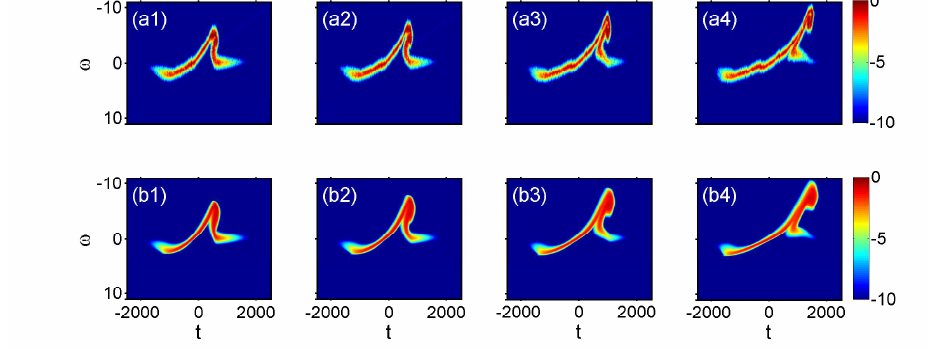
Figure 5. ( a ) Post-collapse dynamics: Numerical simulation of the Vlasov Equation (2) showing the evolution of the intensity of the incoherent pulse N ( t , z ) at the propagation lengths z = 0,80,130,180,220,250,280,310,340, 370,400,430,470,500: The collapse-like behavior at z (cid:39) 220 is regularized as evidenced by the saturation and subsequent relaxation of the amplitude of the incoherent pulse ( σ = − 1, τ R = 300). ( b ) Comparison of the simulations of the NLS equation (1) (light gray, black, dark gray), and of the Vlasov Equation (2) at z = 0 (blue), z = 220 (red) nearby the shock-collapse point, z = 500 (green)—the agreement between the NLS and Vlasov simulations is obtained without adjustable parameters.